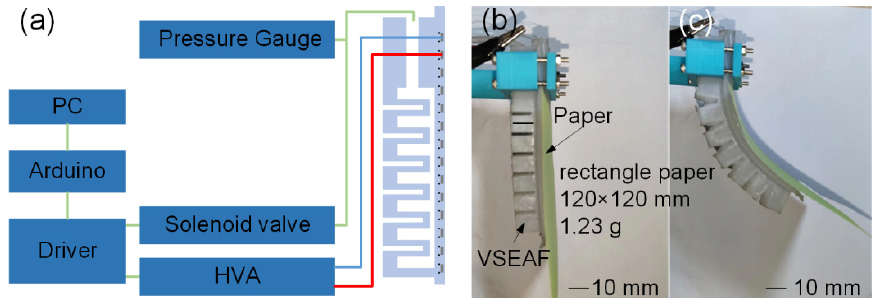
Figure 9. Schematic diagram demonstrating grasping capabilities: ( a ) presentation of the EA grip- ping control system, ( b ) demonstration of flat paper clutching, and ( c ) demonstration of curved pa- per grasping.